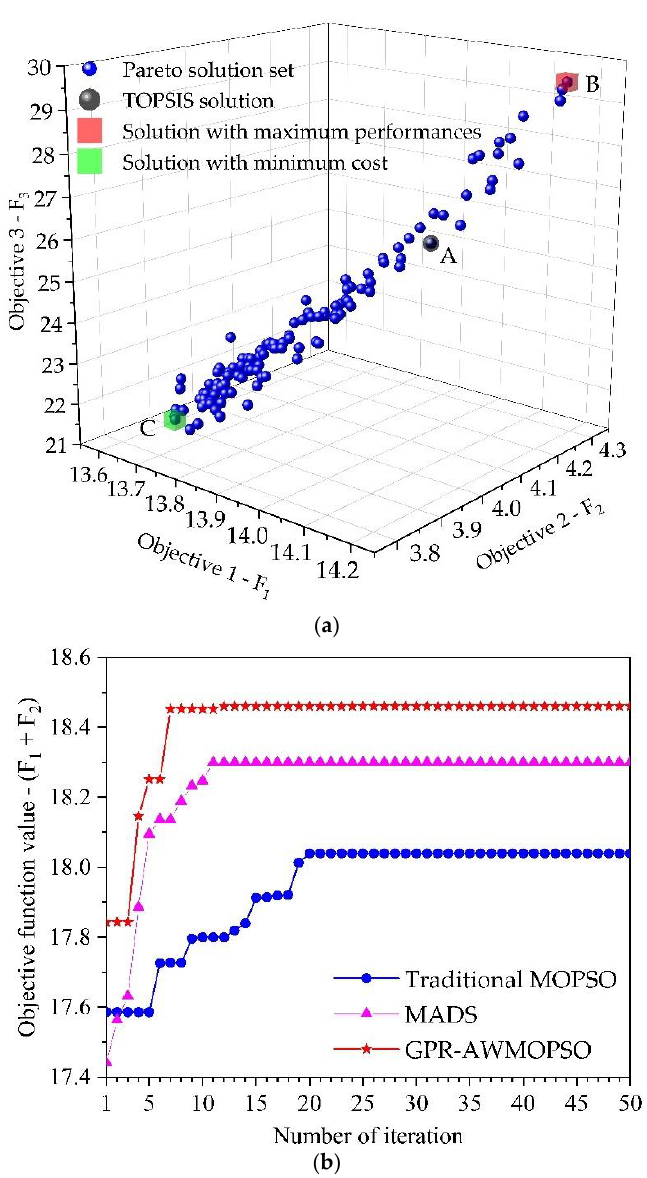
Figure 10. The proportion optimization results for diatomite and basalt fibre modified asphalt mixture using GPR-AWMOPSO: ( a ) Pareto front showing three objectives (F 1 , F 2 and F 3 ) and ( b ) the primary objective function value (F 1 + F 2 ) versus iteration.